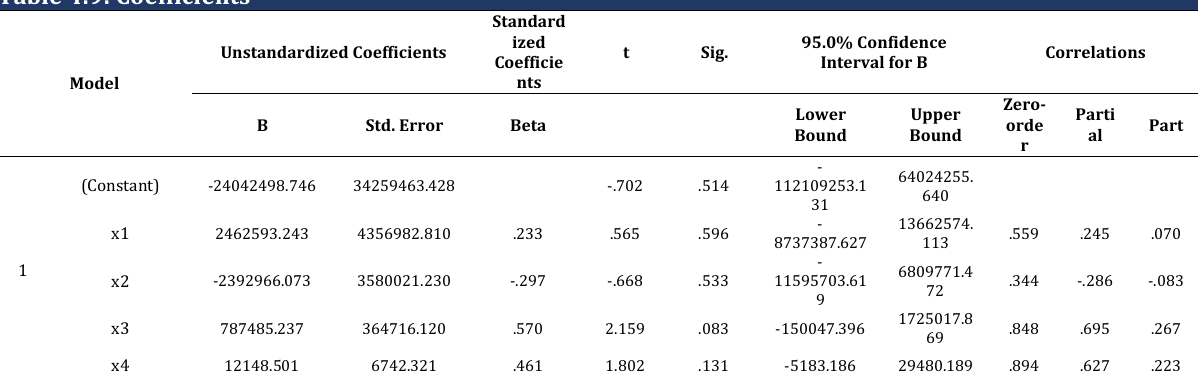
Table 4.9: Coefficients